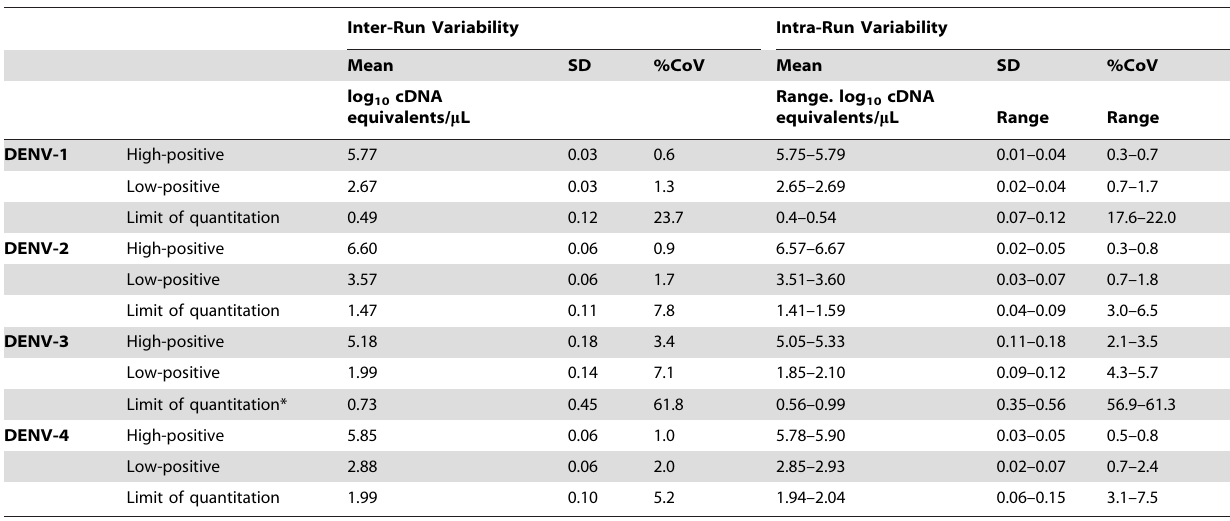
Table 4. Precision analysis of the DENV multiplex rRT-PCR.